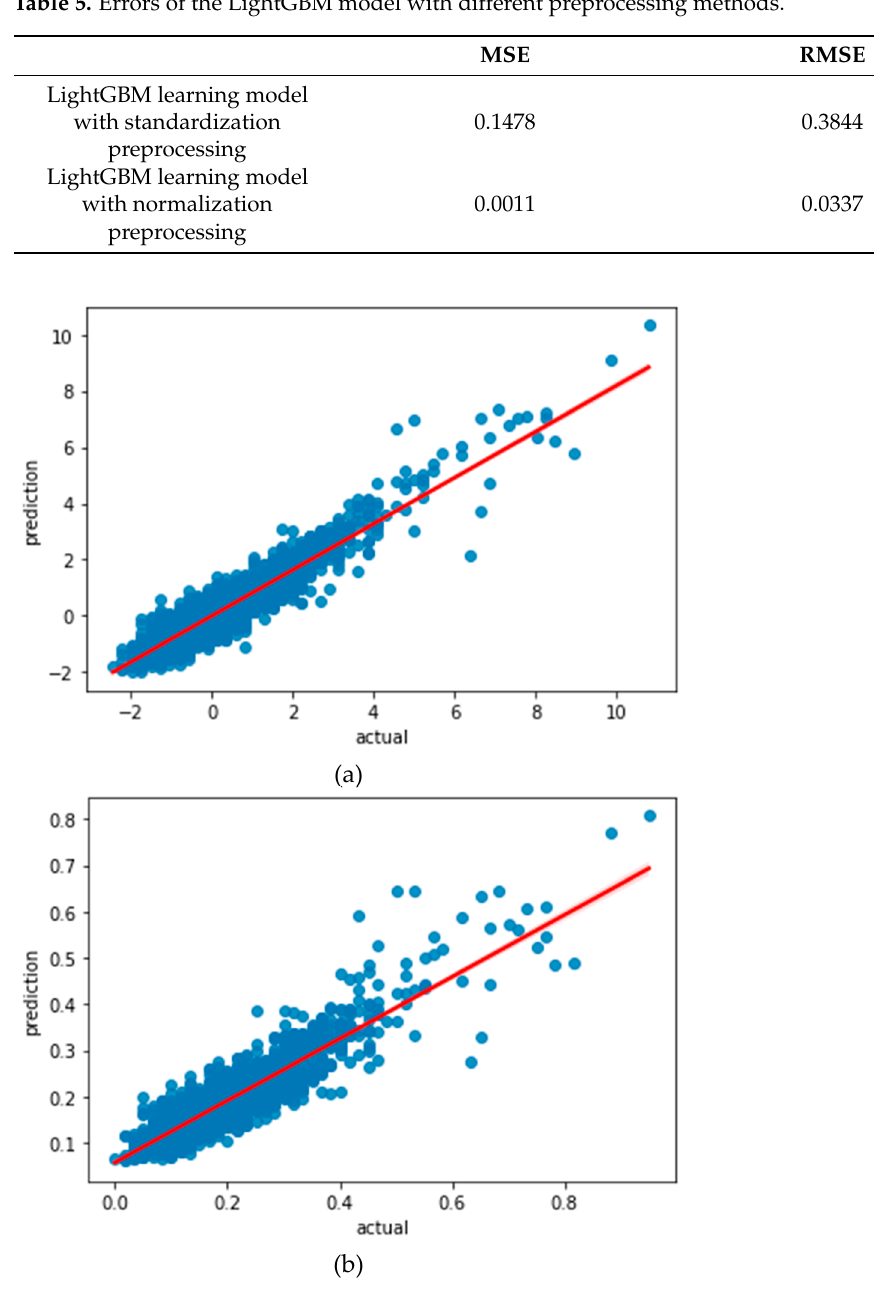
Figure 5. ( a ) Regression curve of the LightGBM learning model with standardization preprocessing; ( b ) regression curve of the LightGBM learning model with normalization preprocessing.